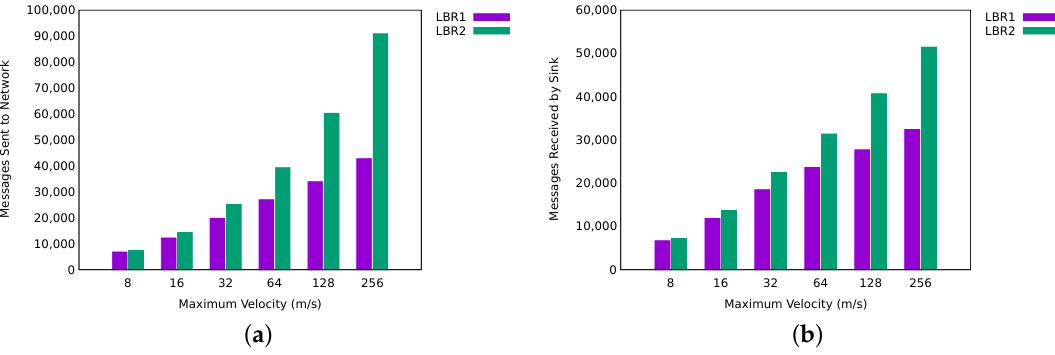
Figure 5. Number of messages sent and received by LBR1 and LBR2 for a maximum velocity of 20 m/s. ( a ) messages sent to network; ( b ) messages received by the sink.